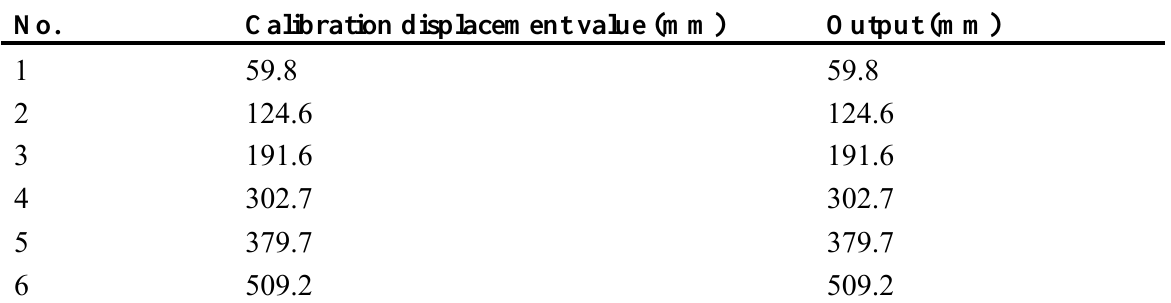
Table 4. Absolute measuring ability test results (extra displacement